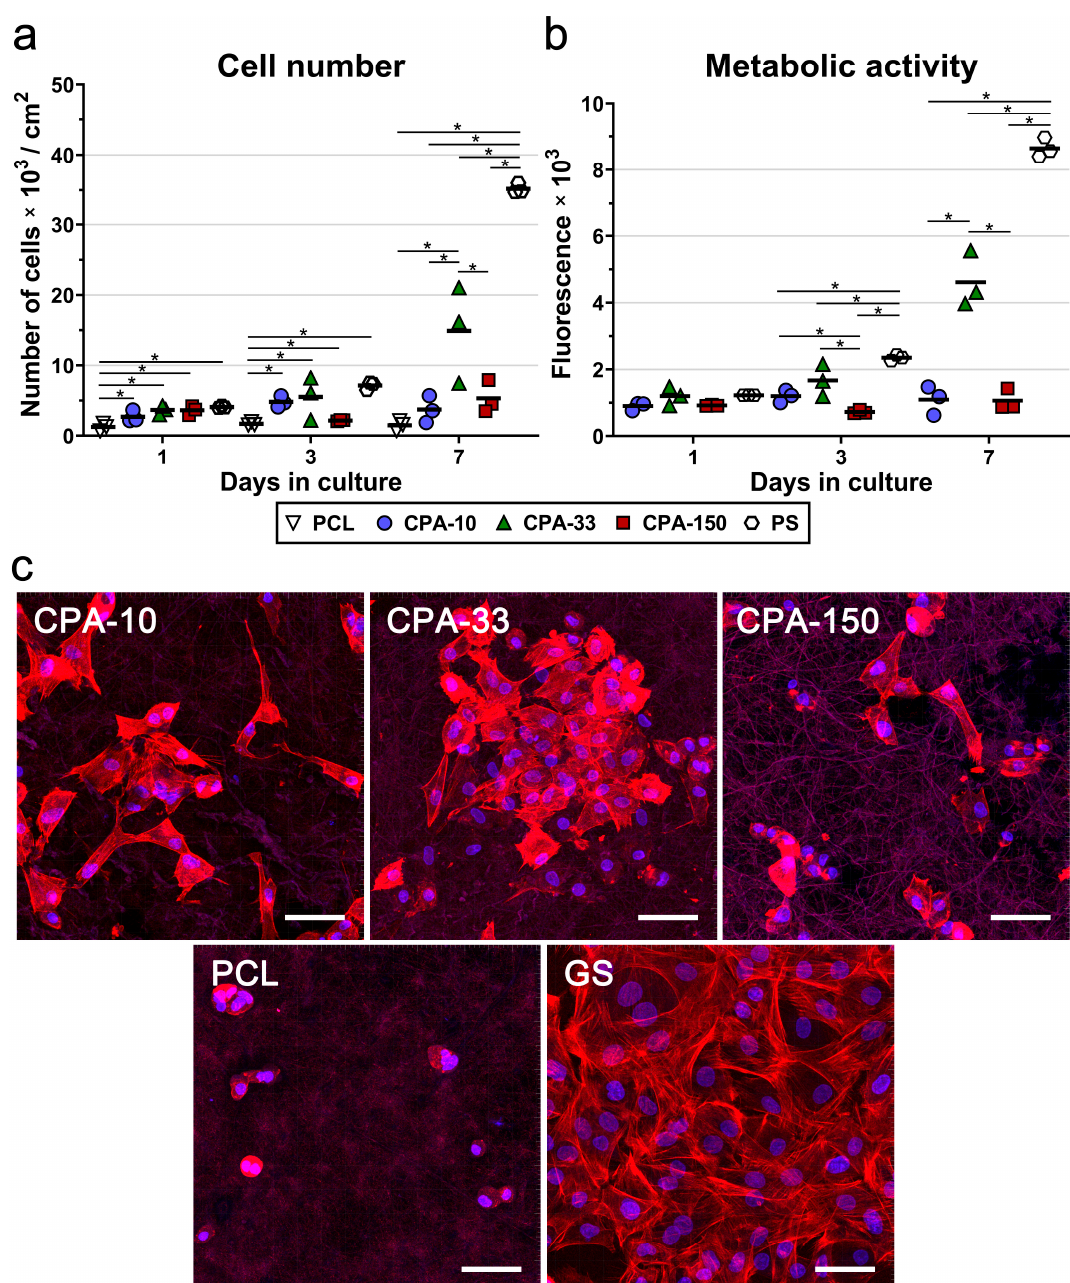
Figure 6. ( a ) Proliferation, ( b ) metabolic activity, and ( c ) morphology of VSMCs cultured on amine-PP-coated PCL NFs, deposited at the average RF power ( P av ) of 10, 33, and 150W (labelled as CPA-10, CPA-33 and CPA-150, respectively), evaluated within 7 days of cultivation. ( a , b ) The dots represent individual biological samples. Each dot depicts the arithmetic mean calculated ( a ) from cell numbers obtained from a minimum of 10 pictures per biological sample or ( b ) from three pipetting replicates per biological sample. The bold central lines show the arithmetic mean of biological samples. Statistically significant differences ( p ≤ 0.05) are marked by horizontal lines with asterisks connecting the differing samples. ( b ) Pristine PCL NFs are excluded from the graph because of their non-specific reaction with the resazurin assay. ( c ) Images of the cells were captured 7 days after seeding by a confocal Leica TCS SP8 microscope. Cell nuclei are visualized by Hoechst #33258 (blue), while the cell membrane and the actin cytoskeleton are visualized by Phalloidin-TRITC (red). GS—glass coverslips. The scale bar depicts 50 μ m.